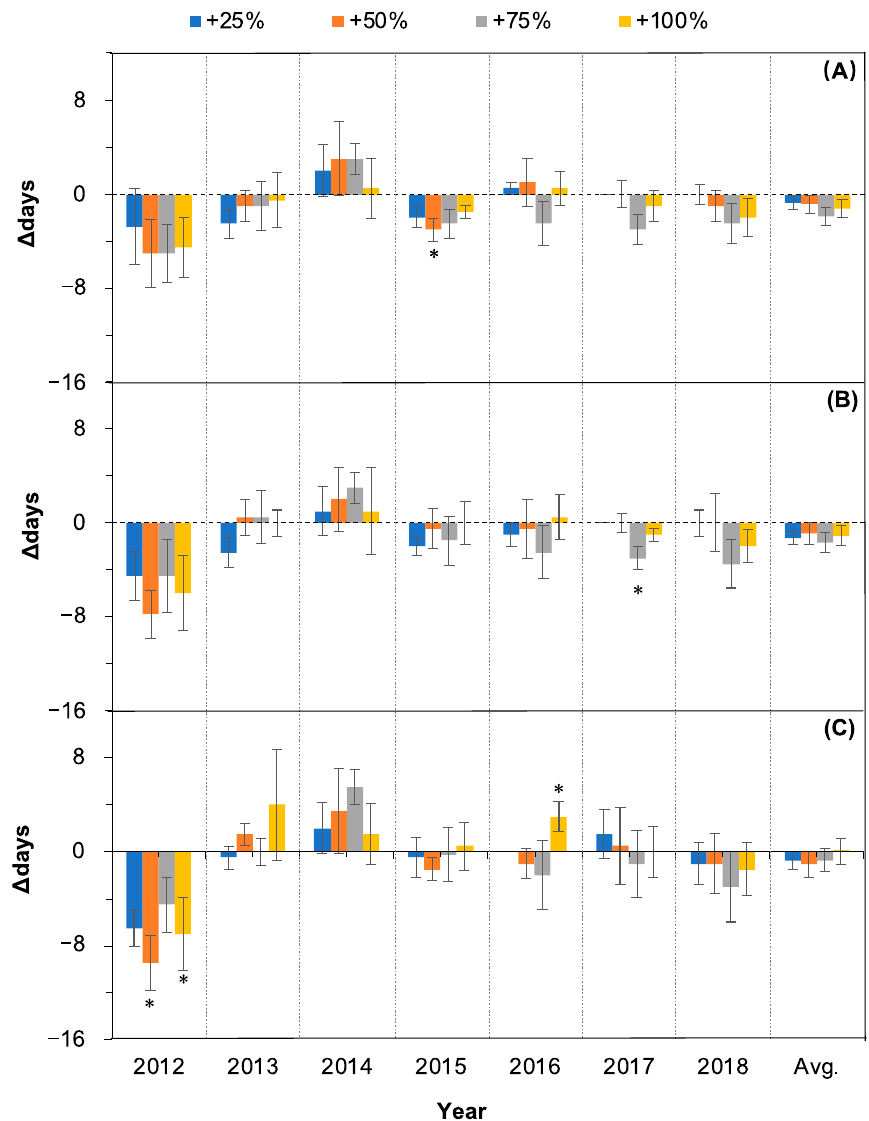
Figure 3. Relative changes ( △ days; mean ± SE) in the three fruit setting events of Nitraria tangutorum after water addition treatments (+25%, +50%, +75%, +100%) compared with the control. Positive and negative values represent delayed and advanced days, respectively. ( A ) OFS, ( B ) PFS, ( C ) EFS. Avg. represents average values over the period from 2012 to 2018. * Significant differences from control.